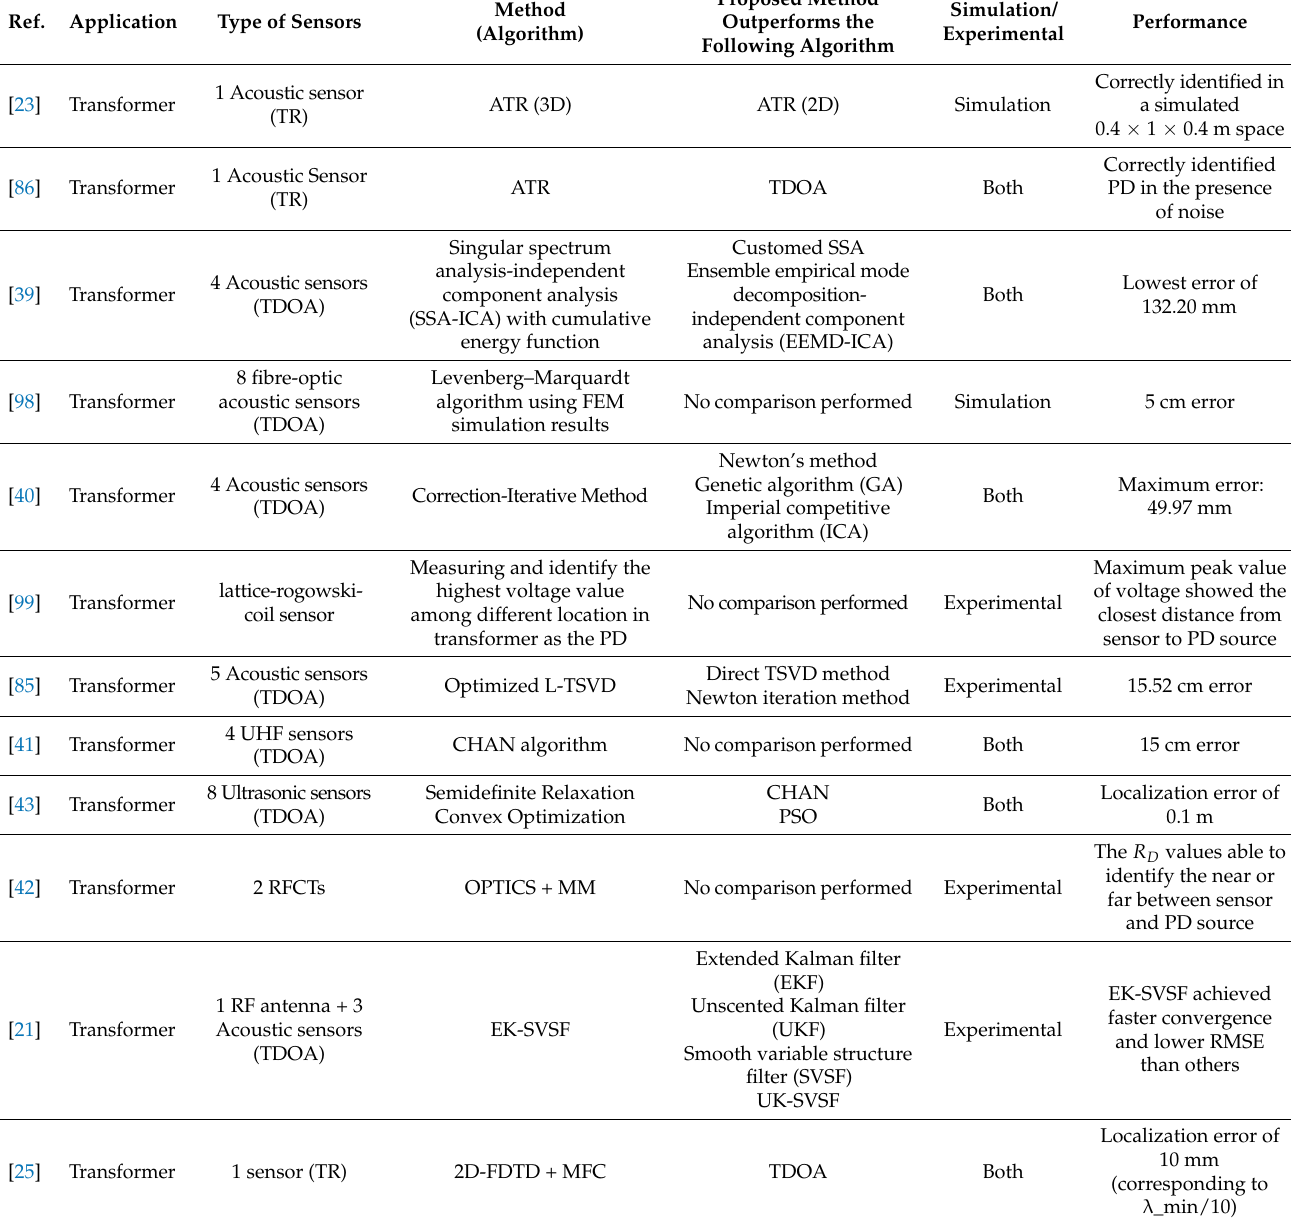
Table 4. Conventional PD